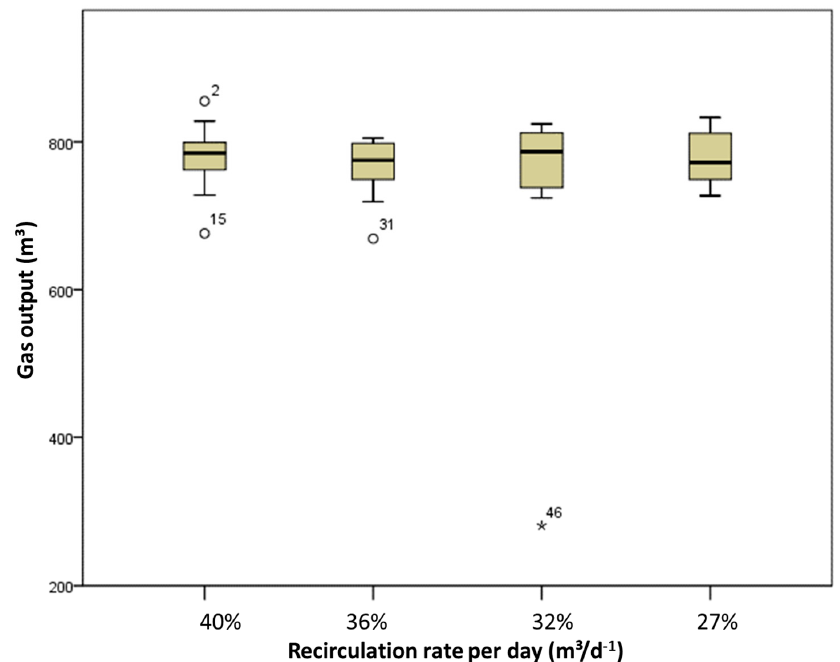
Figure 3. Gas output as a function of recirculation rate ( p < 0.05).